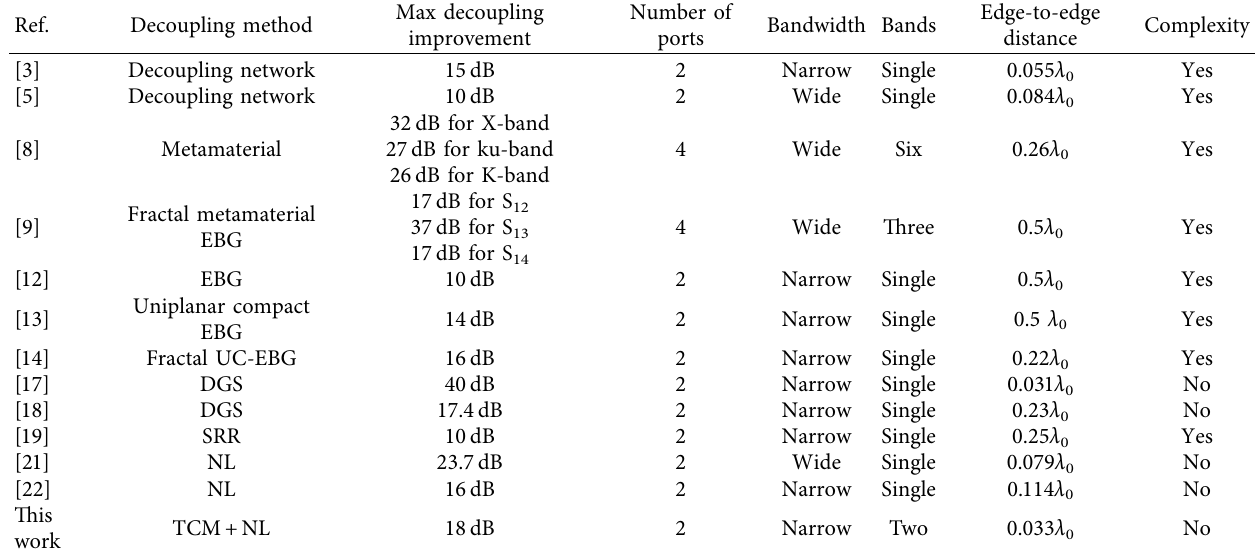
Table 2: Performance comparisons with the previously published literature.